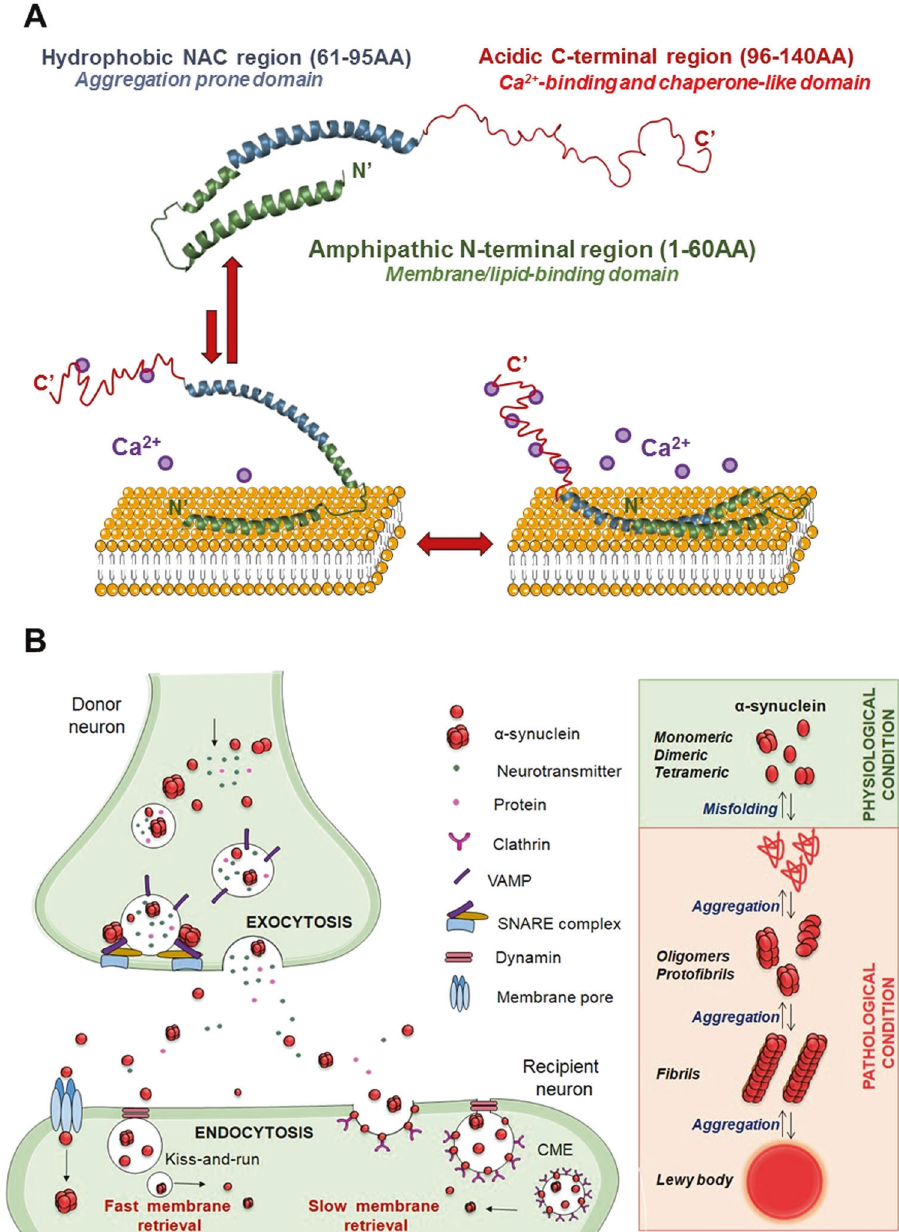
Fig. 1 Modular structure of α -syn and its dynamic interactions with membrane lipids in physiological and pathological conditions. A Alpha-syn is structurally characterized by three modular regions: the N-terminal (green), characterized by amphipathic repetitions, is responsible for interactions with membranes; the hydrophobic NAC (blue), is relevant for aggregation, and the acidic C-terminal (red), is involved in Ca 2 + binding and chaperon-like activity. In the presence of low concentrations of Ca 2 + , α -syn is stably anchored to the lipid surface via its N-terminal region only. With higher Ca 2 + concentrations, also the NAC region, but not the C-terminus, shows lipid-binding properties, suggesting that it plays a different role in modulating the af fi nity of α -syn for cellular membranes. B Left panel: in control conditions, α -syn is important for regulating protein and neurotransmitter release by promoting SNARE complex formation and vesicle docking during the exocytosis process. Extracellular α -syn can affect recipient neurons by fast (i.e., kiss-and-run mode) and slow (i.e., clathrin- mediated endocytosis, CME) modes of membrane retrieval, as several endocytotic pathways can coexist in a single synapse. Interestingly, α - syn is associated with the CME of synaptic vesicles due to its role in sensing and stabilizing the curved membranes. Right panel: under physiological conditions (green), α -syn exists in different conformations balance between unstructured soluble monomeric and tetrameric forms. Under pathological conditions (light red), when the balance between α -syn generation and clearance is disrupted, α ‐ syn aggregates into oligomers, proto fi brils, and fi brils, which further bring to the formation of protein inclusions called LB. fl exible C-terminal ends of the fi brils was demonstrated [17]. These aggregation that leads to rapid multiplication of α -syn, catalyzing the generation of new amyloids from monomers on their surface, intermolecular interactions result in an unfolding process and a process called secondary nucleation. Oligomers produced consequent exposure of the aggregation-prone components of during secondary surface nucleation induce the permeabilization the protein. This condition represents a prerequisite for protein Cell Death and Disease (2023)